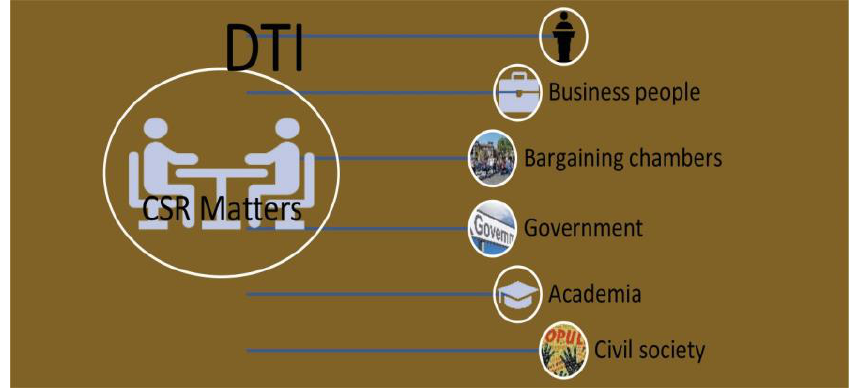
Figure 4: Proposed Csr Coordination Model; Source: